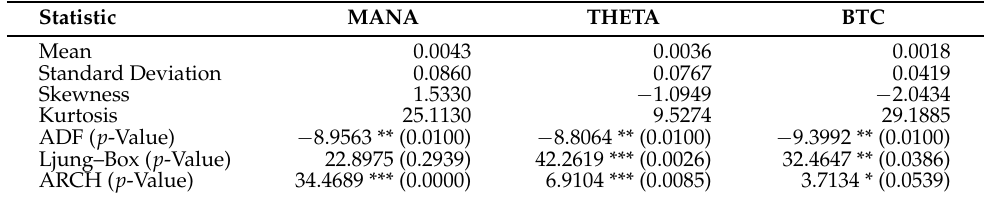
Figure 2. Daily prices and returns of metaverse cryptocurrencies and Bitcoin. Table 4. Summary statistics of metaverse cryptocurrencies and Bitcoin